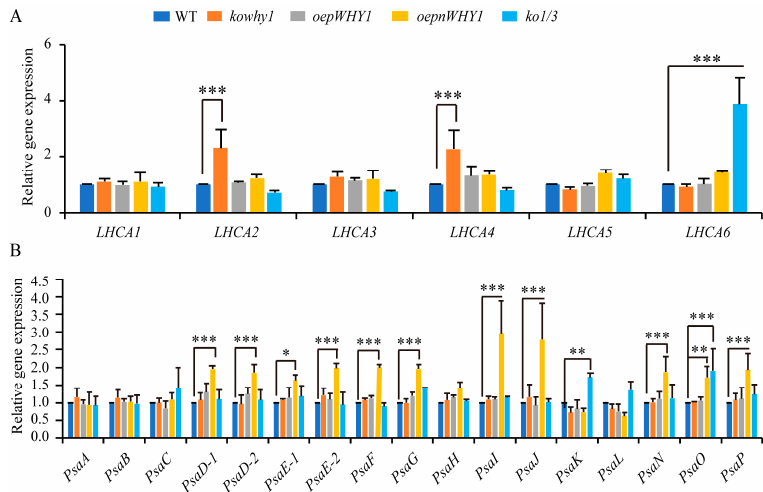
Figure 2. Expression of photosystem I (PSI)-light harvest complexes (LHCI) encoded genes in WHY1 mutants and wild-type plants ( A ) Expression analysis of LHCI complex encoded genes in WHY1 mutants and wild-type plants by qPCR; ( B ) Expression analysis of PSI core complex encoded genes in WHY1 mutants and wild-type plants. The transcript level in each case was normalized to that of GAPC2 as a reference gene, and the expression level of WT was set as 1. Three biological replications were used to analyze. Asterisk indicate significant differences in gene expression compared to